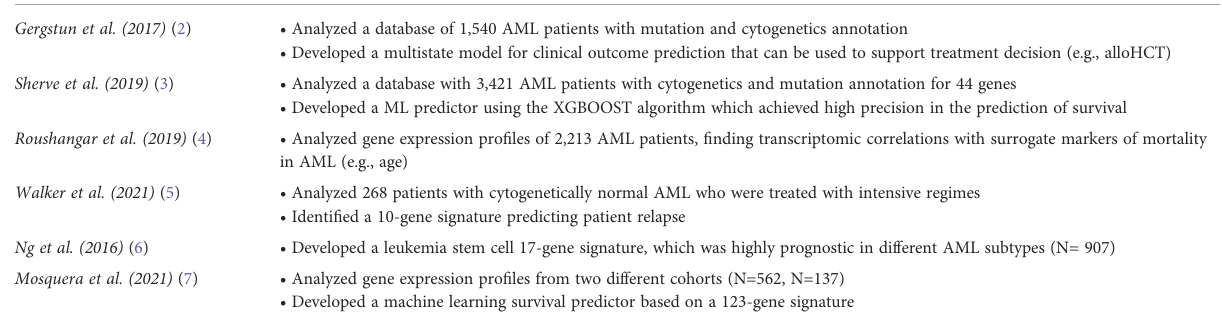
TABLE 1 Summary of the molecular predictors of AML survival described in the main